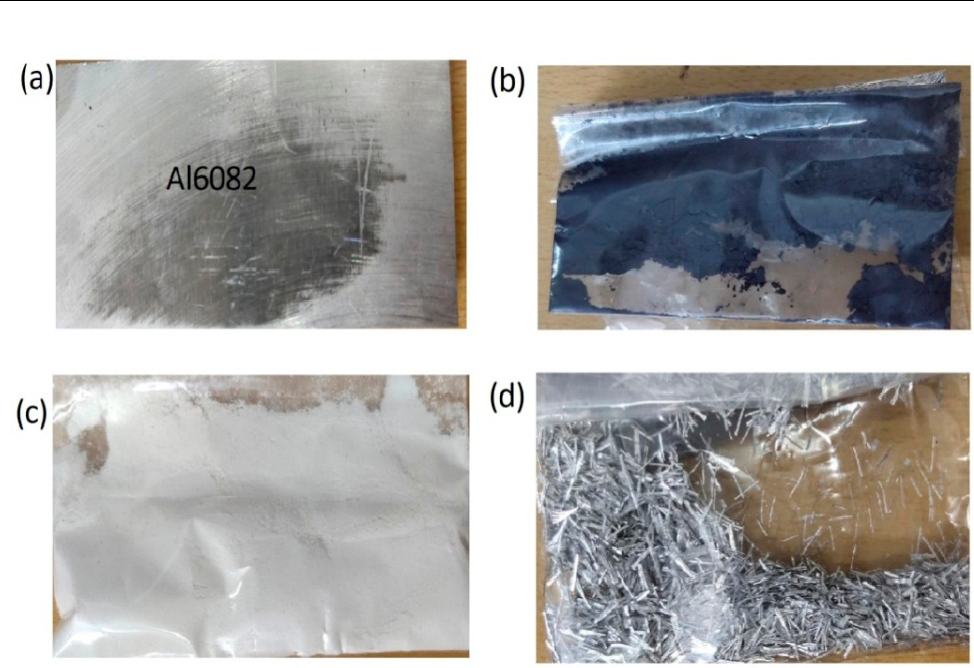
Figure 1. Photograph of; ( a ) Al6082, ( b ) Si 3 N 4 , ( c ) eggshells powder, ( d )